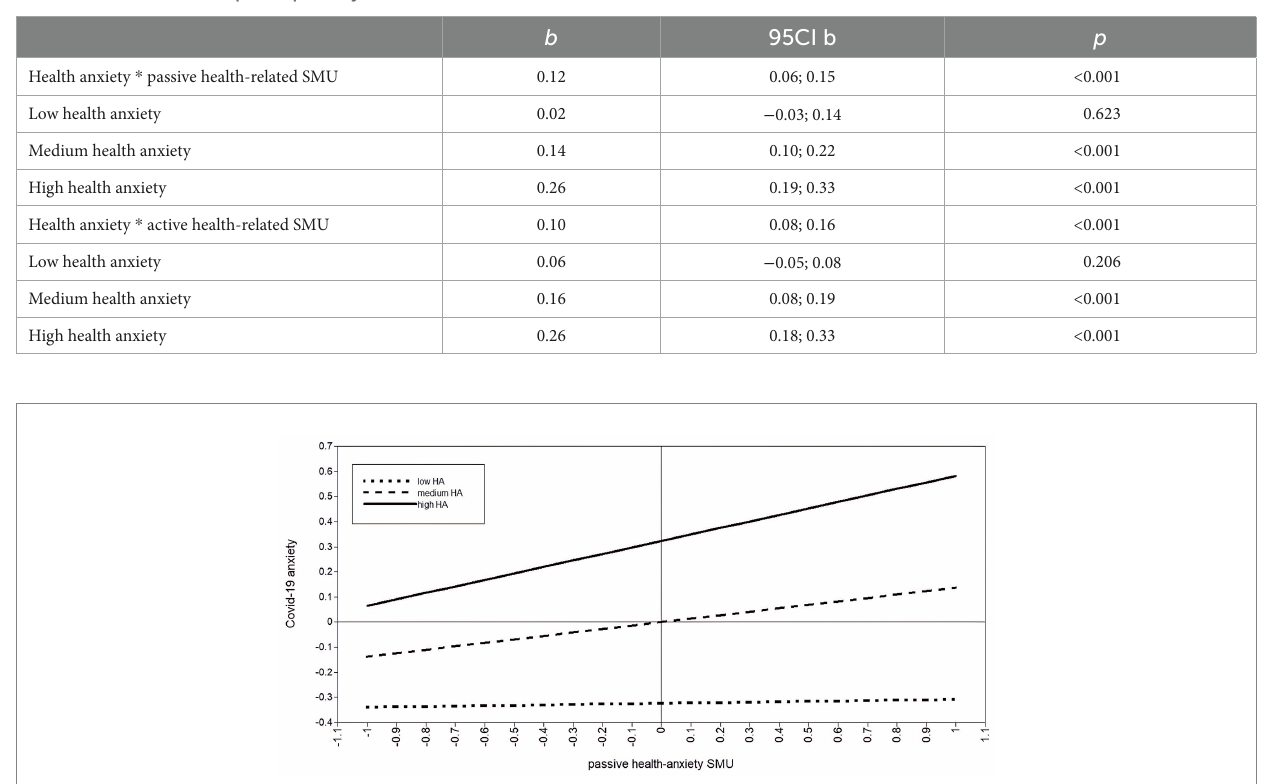
FIGURE 3 Moderating role of health anxiety between passive health-related SMU and COVID-19